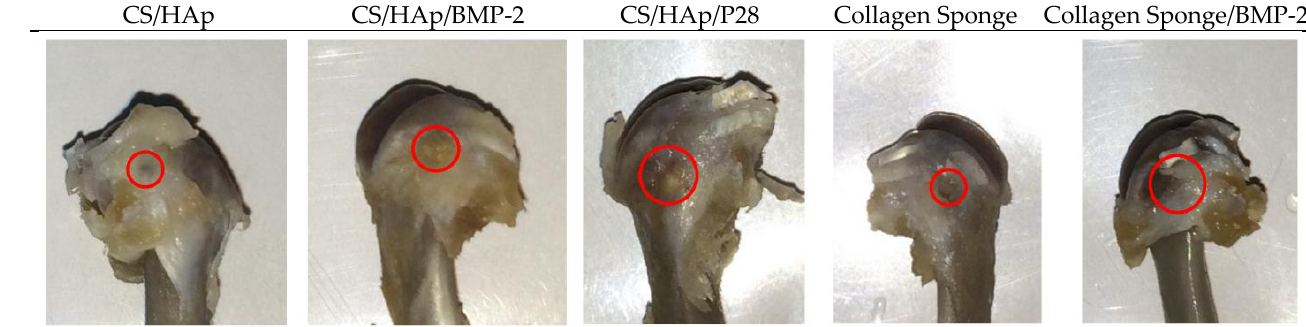
Figure 6. Defects visibility on the condyles after eight weeks (red circle). Traces of defects were still visible and appeared as small irregular bumps, especially in condyles with the implanted CS/HAp scaffolds.